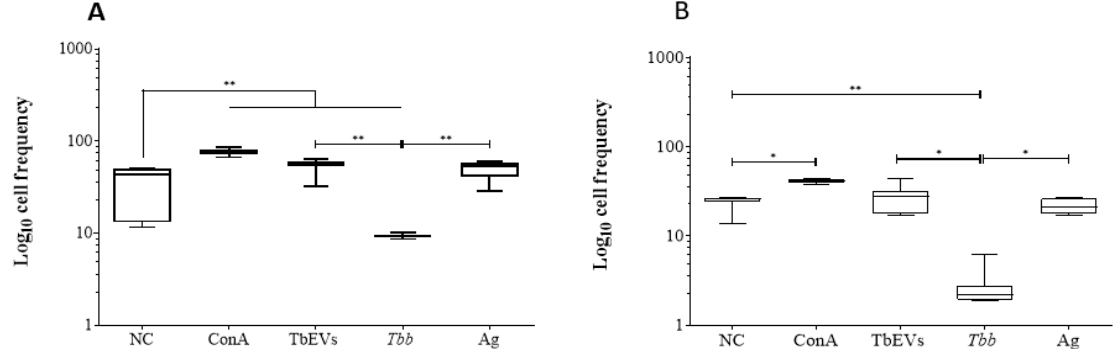
Figure 7. Frequency of CD3 + cells after exposure of mononuclear cells to TbEVs. CD4 + ( A ) and CD8 + ( B ) cell fractions exposed to T. b. brucei parasites ( Tbb ), stimulated by parasite antigen (Ag), TbEVs, and ConA, and unprimed cells (negative control, NC) were labelled with CD3-monoclonal antibody and evaluated by flow cytometry. Results of at least three independent experiments ( n = 20) performed in duplicate are represented by whiskered box-plot, median, minimum, and maximum values. The non-parametric Wilcoxon matched-pair signed-rank test was used for statistical comparisons. * ( p < 0.05) and ** ( p < 0.01) indicate significant differences.